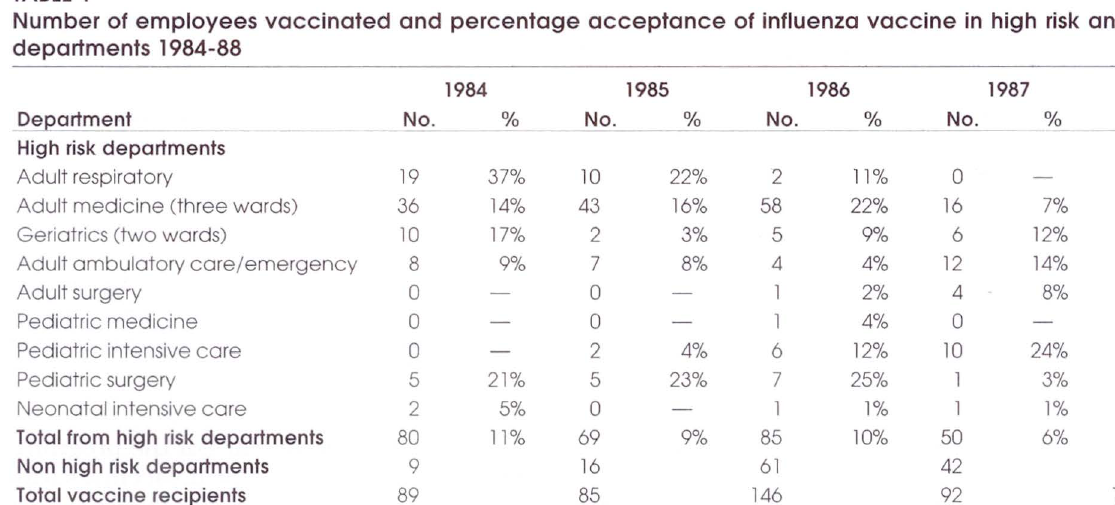
Number of employees vaccinated and percentage acceptance of influenza vaccine in high risk and non high risk departments 1984-88